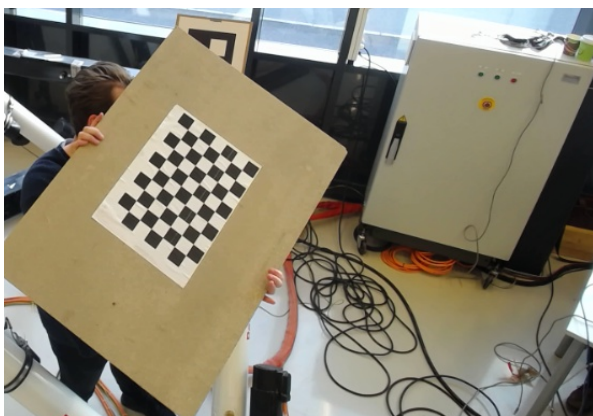
Figure 8: One of the pictures used to calibrate the cam- era using the Matlab camera calibration tool-